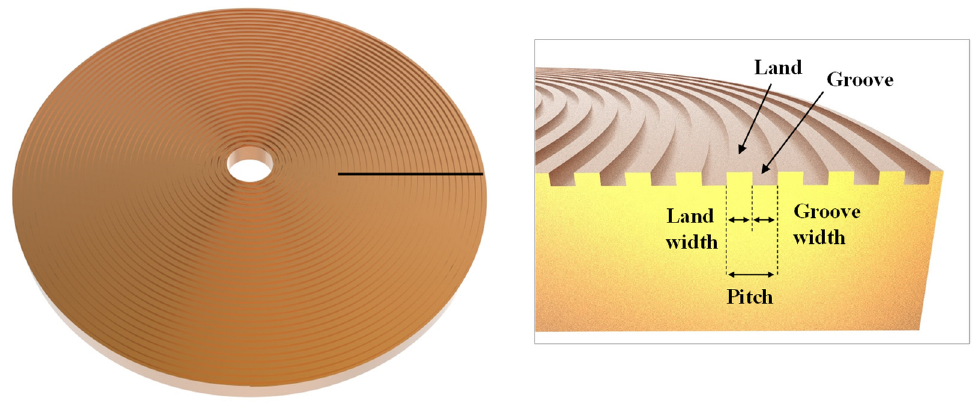
Figure 1. Lapping platen and groove on platen surface.